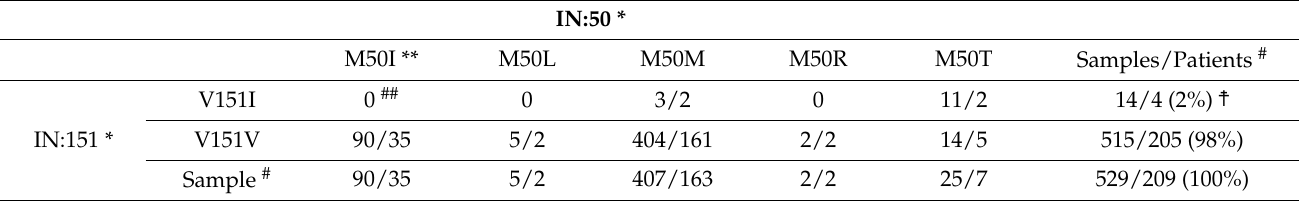
Table 2. Population analysis of IN:V151 variation in NIAID samples.